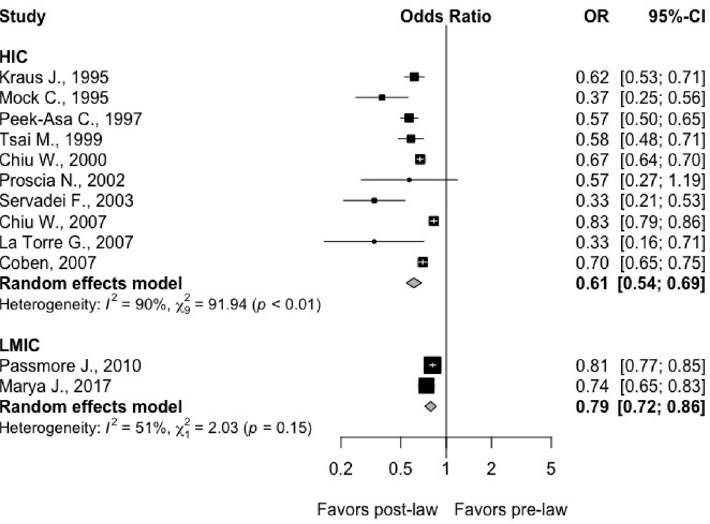
Fig 4. Forest plots demonstrating the OR for TBI following implementation of helmet legislation (95% CI) in HICs from 9 studies and in LMICs from 2 studies. Solid squares represent the point estimate of each study, and the centers of the clear diamonds represent the estimate of the intervention effect for HIC vs. LMIC, while the center for the black diamond represents the overall OR for all studies. Horizontal lines represent 95% CIs for the original studies, and the width of the diamonds represents the 95% CI of the pooled ORs. Prediction interval for the OR of TBI comparing post- to pre-law enactment for HIC: (0.42; 0.88). In 95% of all meta-analyses in HIC, the range of the prediction interval will capture the true effect size of 95% of all new studies in HIC. Prediction interval for the OR of TBI comparing post- to pre-law enactment for LMIC: NA due to paucity of studies. CI, confidence interval; HIC, high- income country; LMIC, low- and middle-income country; OR, odds ratio; TBI, traumatic brain injury.